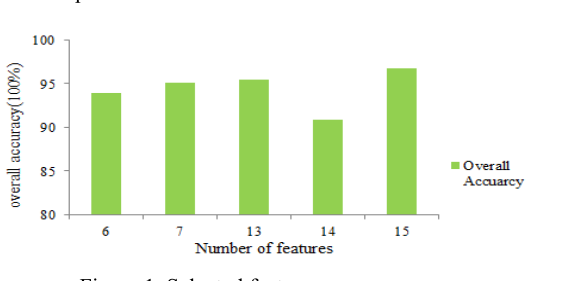
Figure 1. Selected